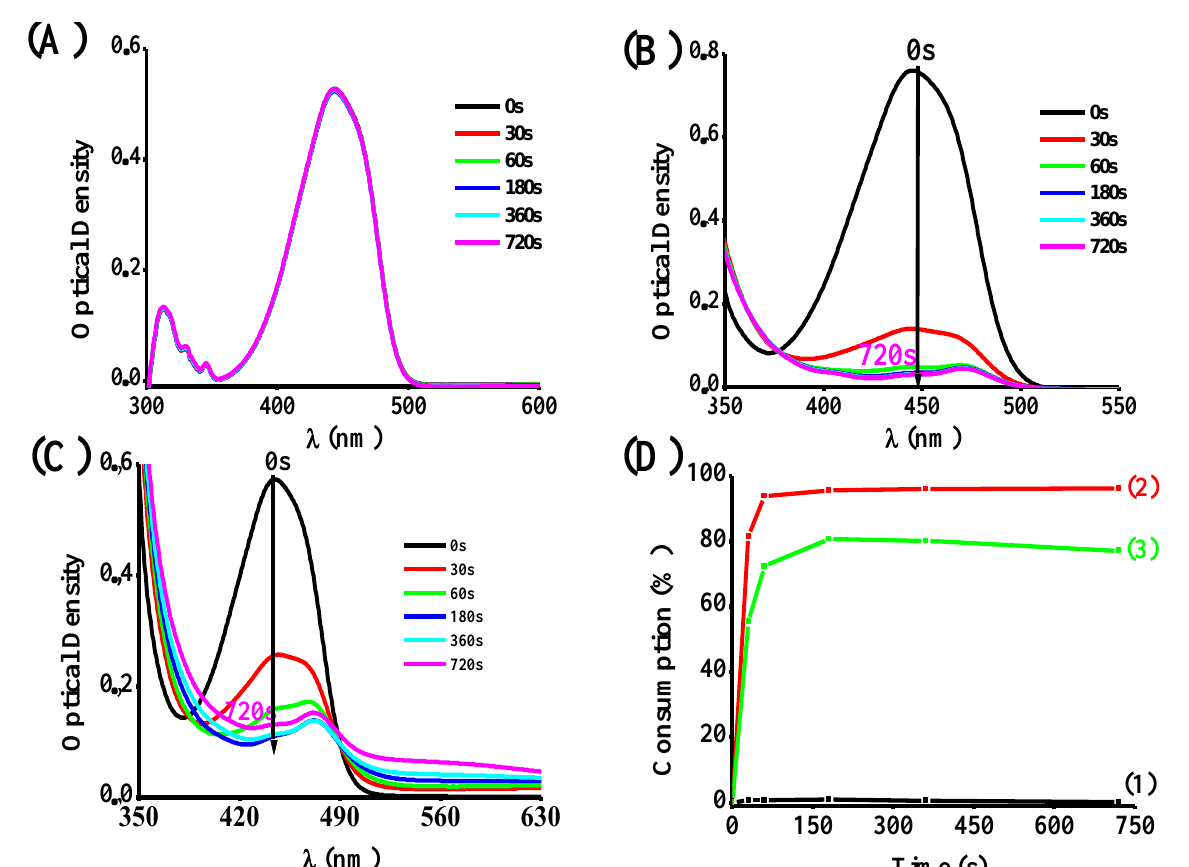
Figure 6. Photolysis experiments of Napht-1 in chloroform: ( A ) alone, ( B ) with Iod salt (10 − 2 M), and ( C ) with Iod/NPG (10 − 2 M) couple. ( D ) Consumption percentage of Napht-1: (1) Without additives, (2) With Iod, and (3) With Iod/NPG.